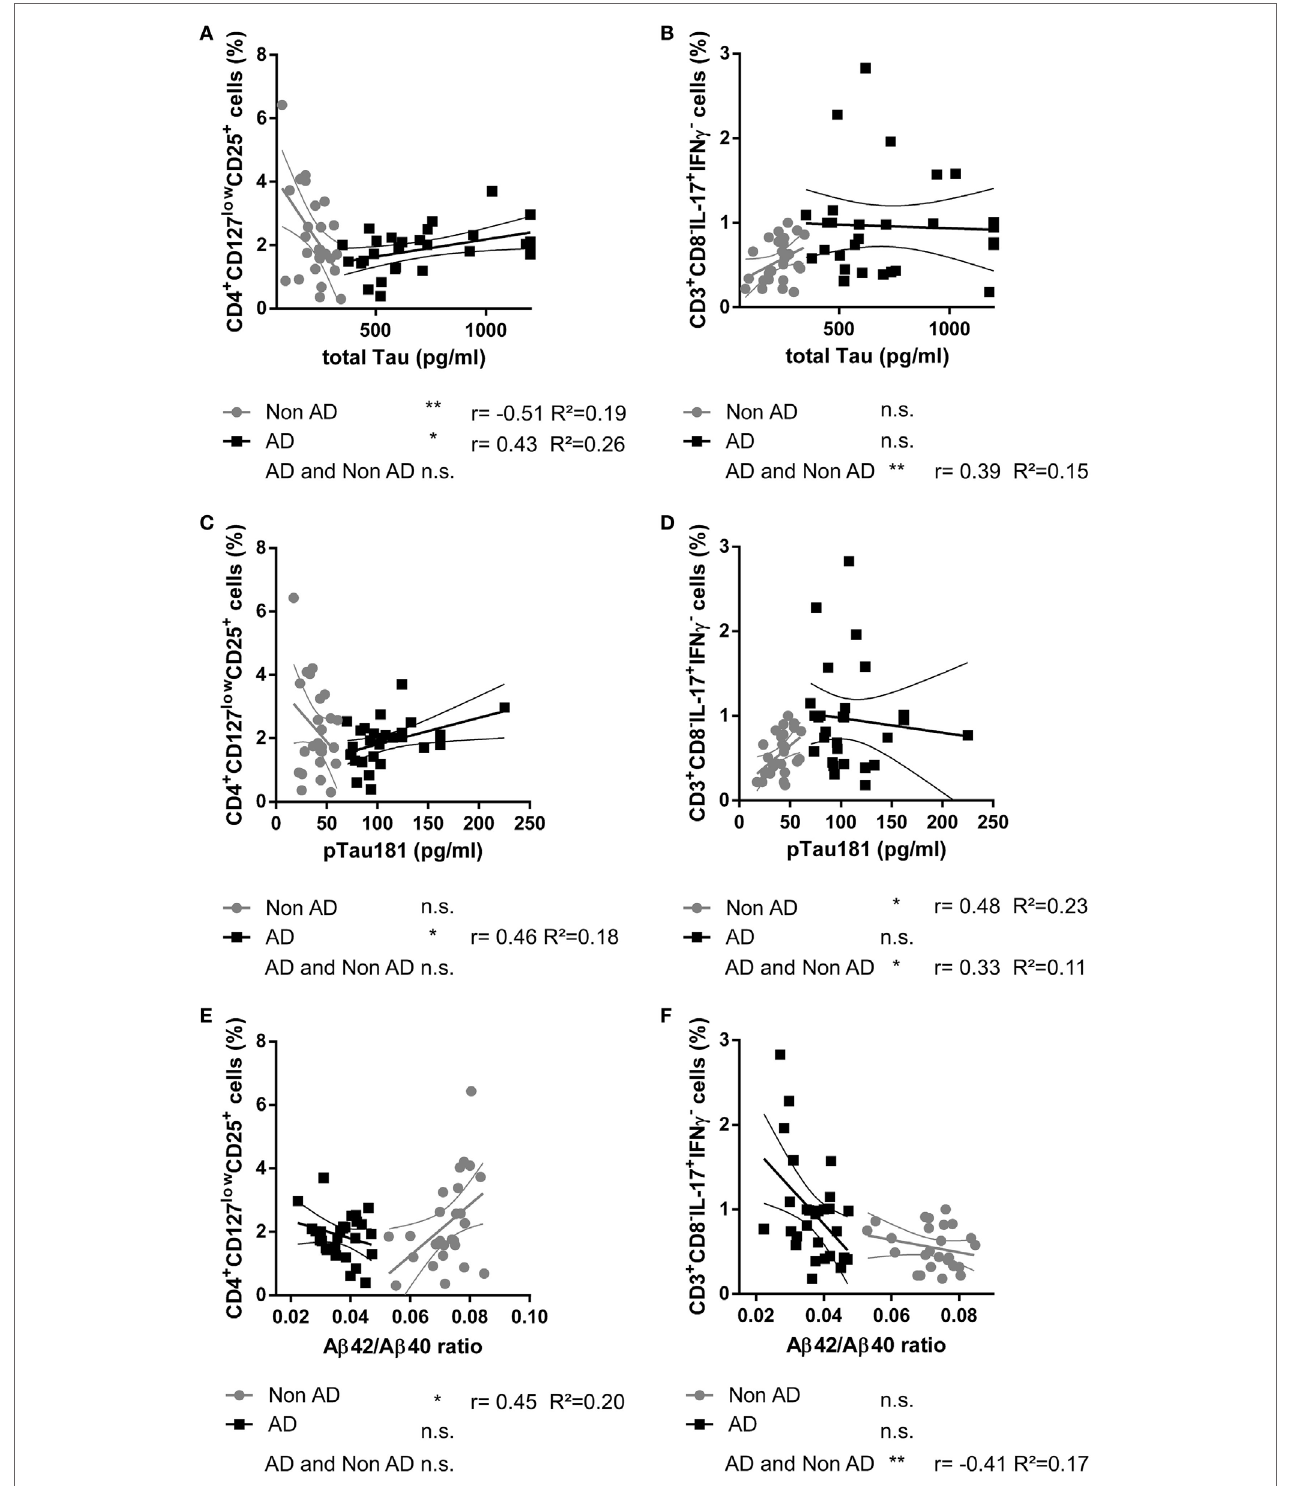
FigUre 2 | Scatter plots showing the relationship between the cerebrospinal fluid level of total Tau protein [pg/ml; (a,B) ], pTau181 [pg/ml; (c,D) ], A β 42/A β 40 ratio (e,F) , and the percentage of CD4 + CD127 low CD25 + T regs (a,c,e) and CD3 + CD8 − IL-17 + IFN γ − T h 17 cells (B,D,F) in donors with Alzheimer’s disease (AD, black squares) and controls (nonAD, gray dots). The associations in AD group, nonAD group and all subjects combined were investigated with Spearman’s correlation. (Scatter plots with the linear regression lines for AD and nonAD groups and their 95% confidence intervals are shown; non-significant = n.s., * p < 0.05, ** p < 0.01, ** p < 0.001; r : Spearman’s correlation coefficient; R 2 : coefficient of determination.)